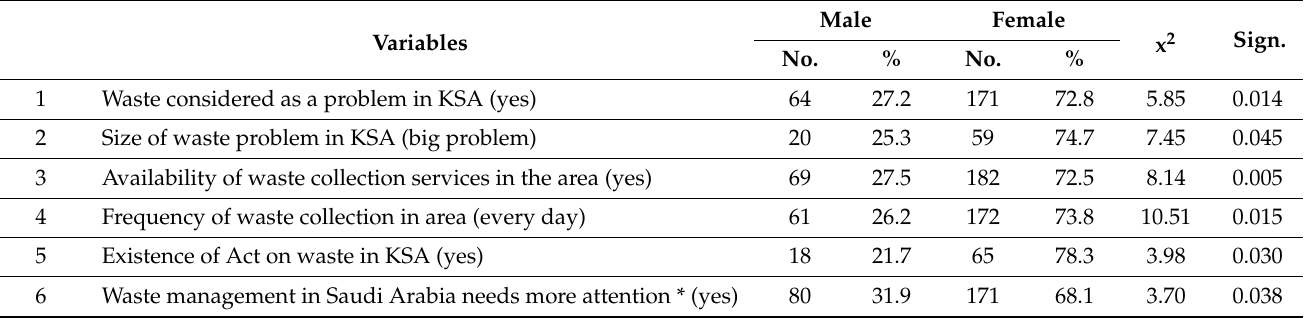
Table 2. Households’ variations based on their gender regarding waste management ( n = 279).